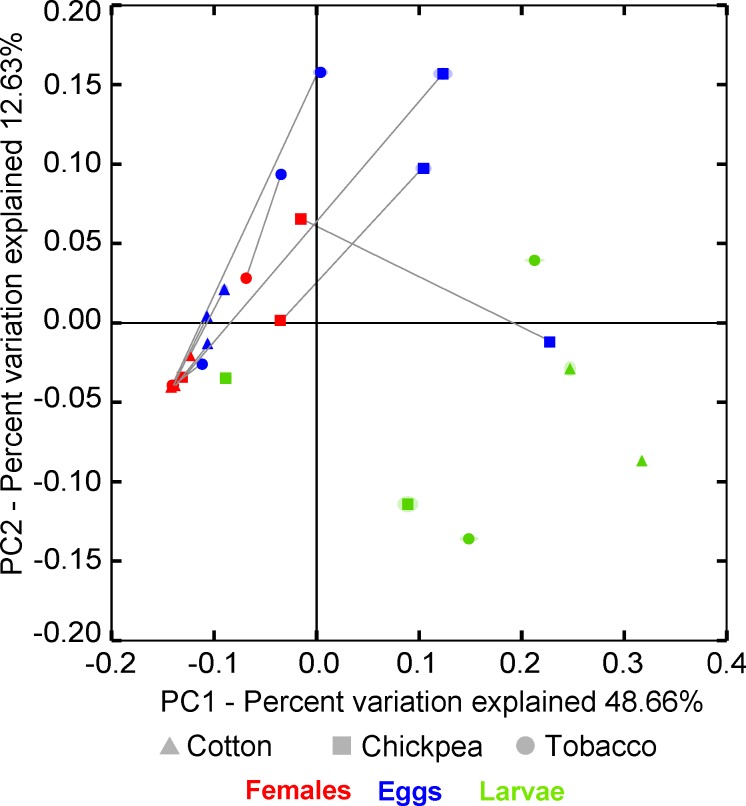
Principal coordinates analysis plot of bacterial communities of field larvae, female adults and their eggs.Absence of confidence ellipsoids around the samples indicates good jackknife support for the location of data points in the PCoA plots. Colors indicate life stages; symbols denote food plant; lines connect female-egg combinations.